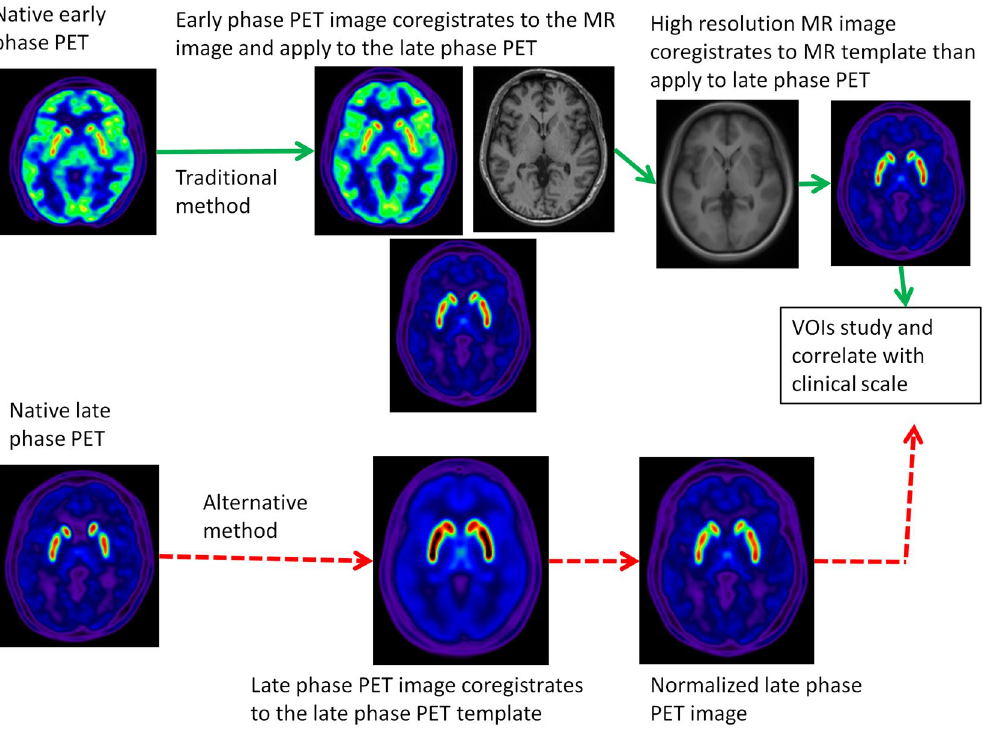
Figure 1. Schematic representation of the analysis process for the late phase 18 F-DTBZ PET